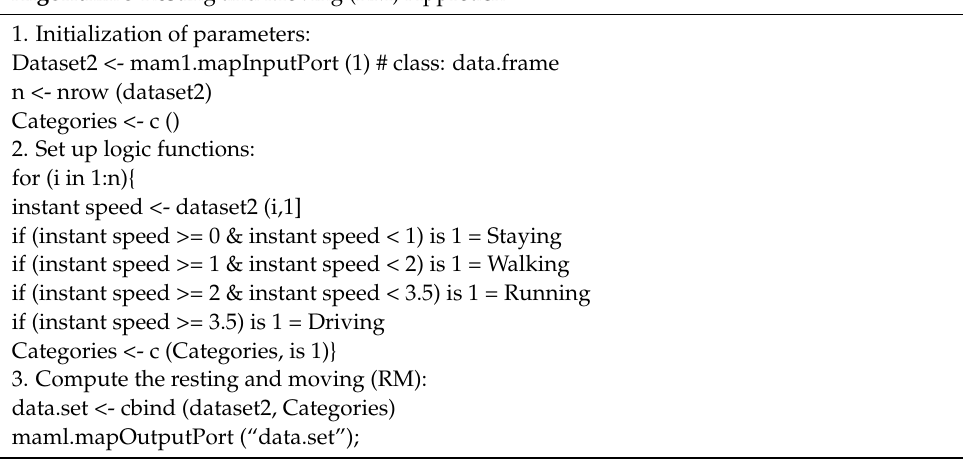
Algorithm 3 Resting and Moving (RM)